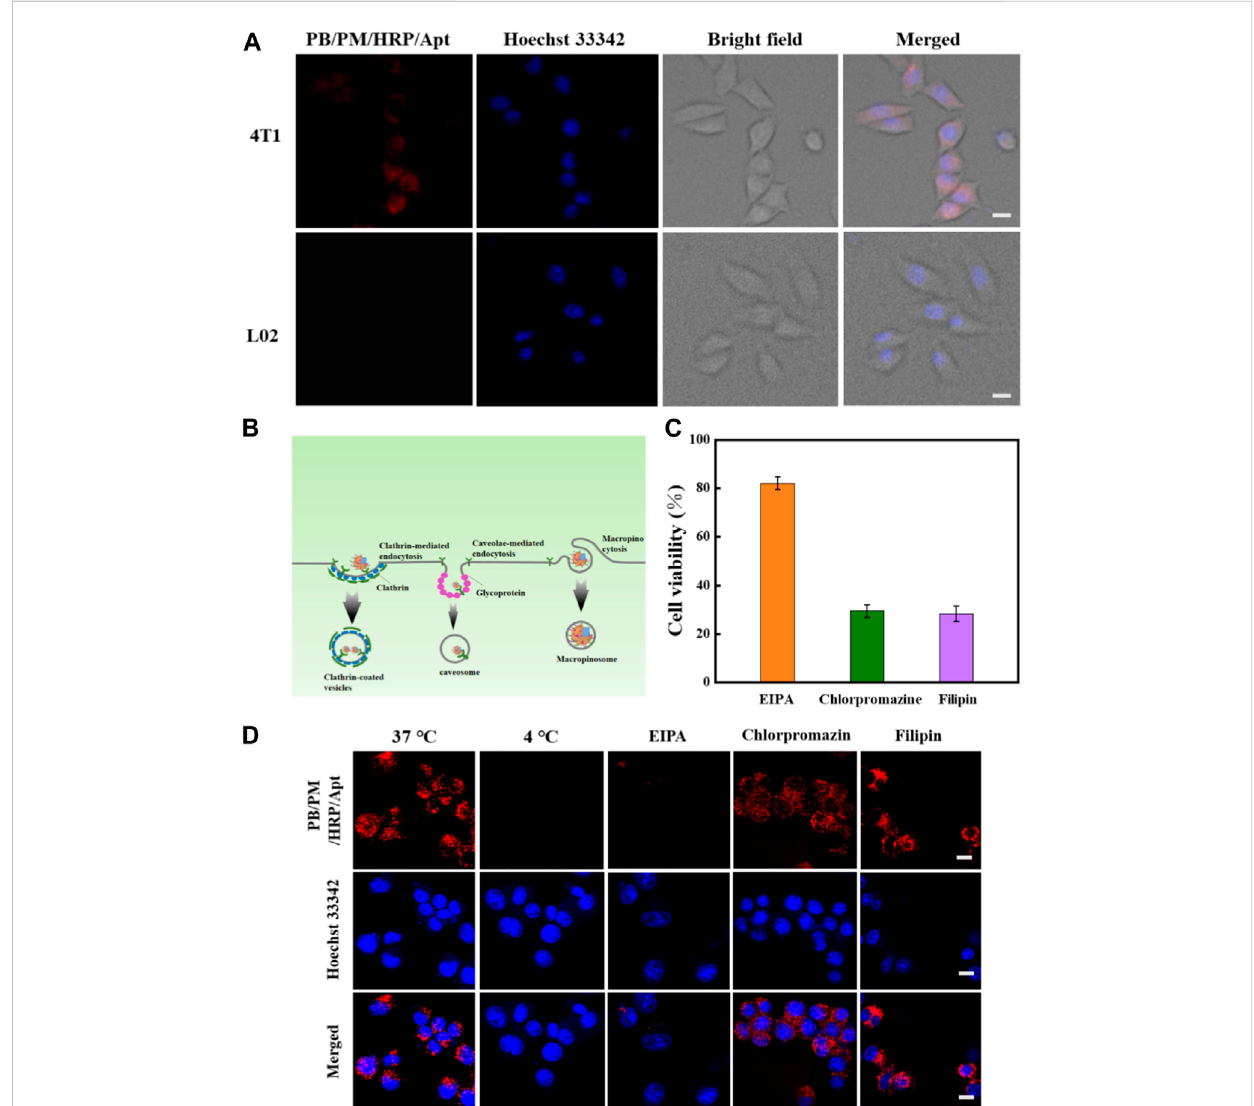
FIGURE 4 Invitro study ofendocytosis mechanism ofPB/PM/HRP/Apt. (A) Cellular internalization ofPB/PM/HRP/Apton4T1 cells andL02cells. (B) Schematic representationofclathrin-mediatedendocyticpathway,caveolaemediatedendocyticpathway,andmacropinocytosis. (C) Cytotoxicitydataafteradding differentinhibitors. (D) CLSMimagesofPB/PM/HRP/Aptin4T1cellspretreatedwithvariousendocytosisinhibitors(EIPA,Chlorprozine,Filipin)andat37 ° C or 4 ° C. Scale bar: 10 μ